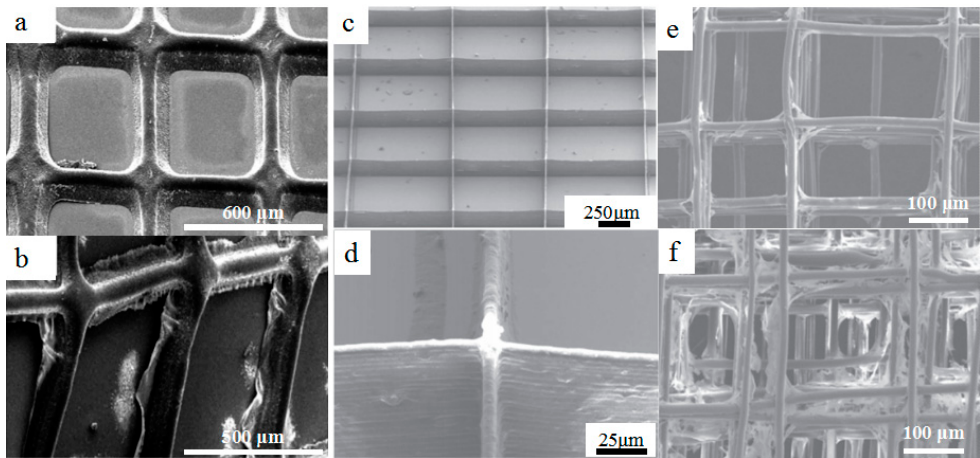
Figure 5. 3D printed biopolymer with micro-/nano-scale structures. ( a , b ) Electrohydrodynamically printed drug-loaded polycaprolactone (PCL) polymer patches and drug-loaded PCL–polyvinyl pyrrolidone (PVP) patches after 90 mins drug release, reprinted from [48] with the permission of Nature Publishing Group, Copyright 2017; ( c , d ) SEM images of electrohydrodynamically printed polyethylene oxide (PEO)–PCL scaffolds with multiwall carbon nanotube (MWCNT) content of 0.5 w/v %, reprinted from [55] with the permission of IOP Publishing, Copyright 2017; ( e , f ) SEM characterizations of melt electrohydrodynamic 3D-printed cell scaffold constructs cultured for 7 days; ( e ) SEM images of cell morphology in the scaffolds with a fiber spacing of 250 μ m; ( d ) SEM images of cell morphology in the scaffolds with a fiber spacing of 100 μ m, reprinted from [56] with the permission of IOP Publishing, Copyright 2017.